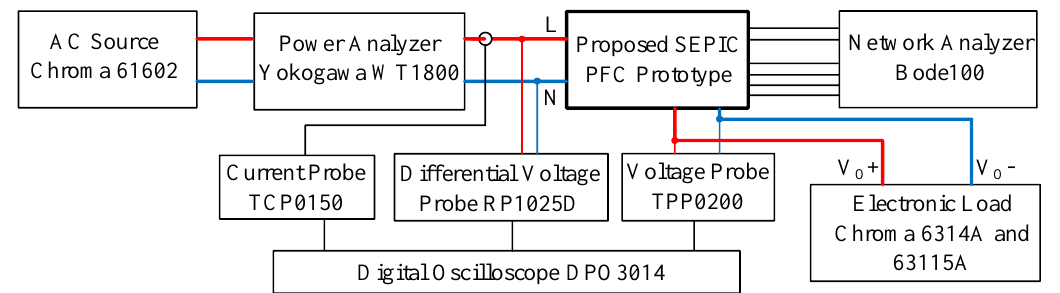
Figure 17. Block diagram of the experimental platform .